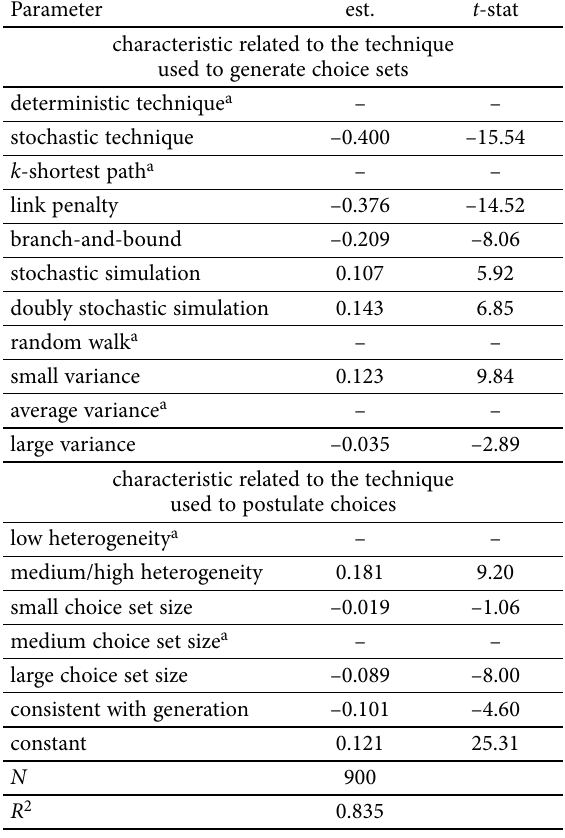
Table 9. Meta-analysis estimates of the mean average prediction